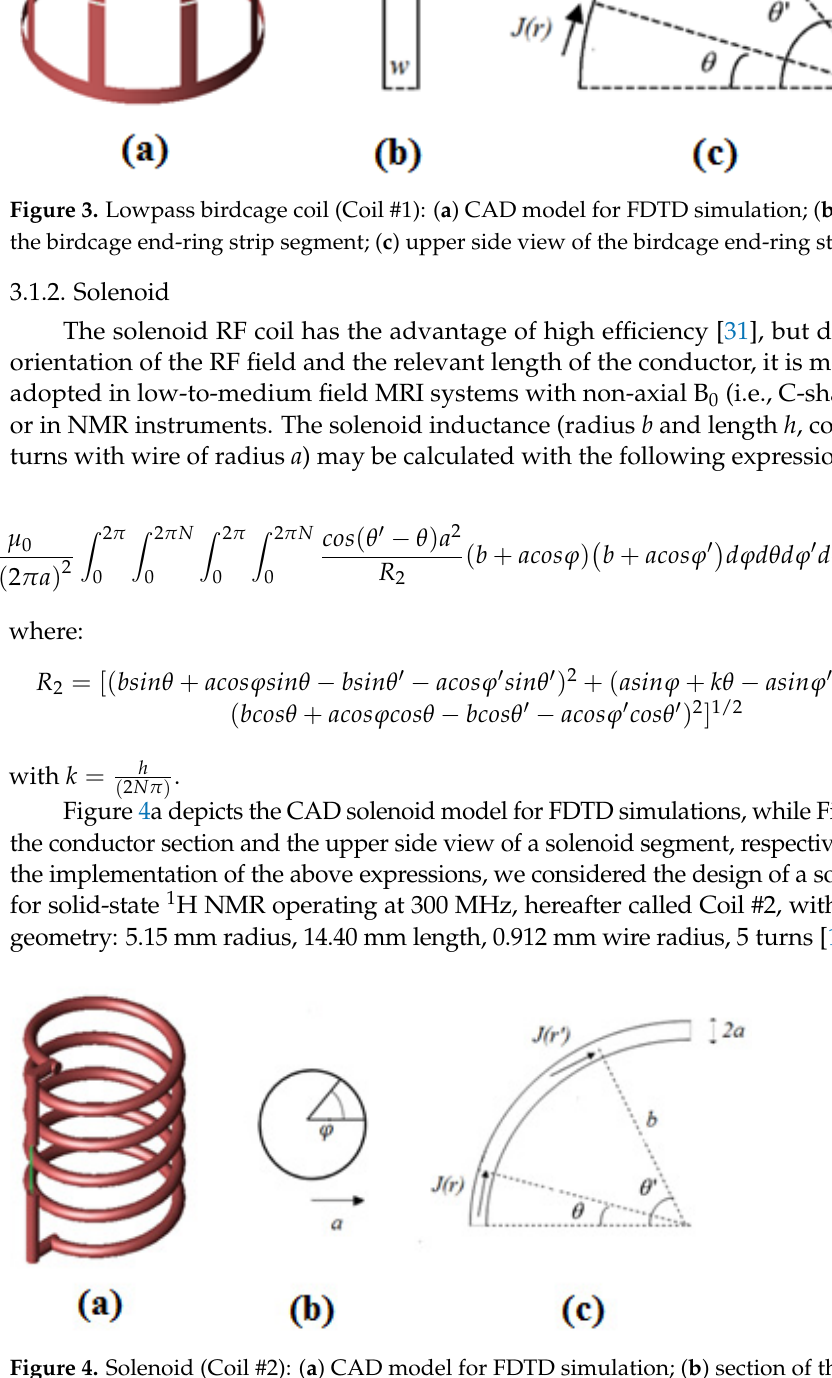
Figure 4. Solenoid (Coil #2): ( a ) CAD model for FDTD simulation; ( b ) section of the wire solenoid conductor; ( c ) upper side view of the wire solenoid segment.